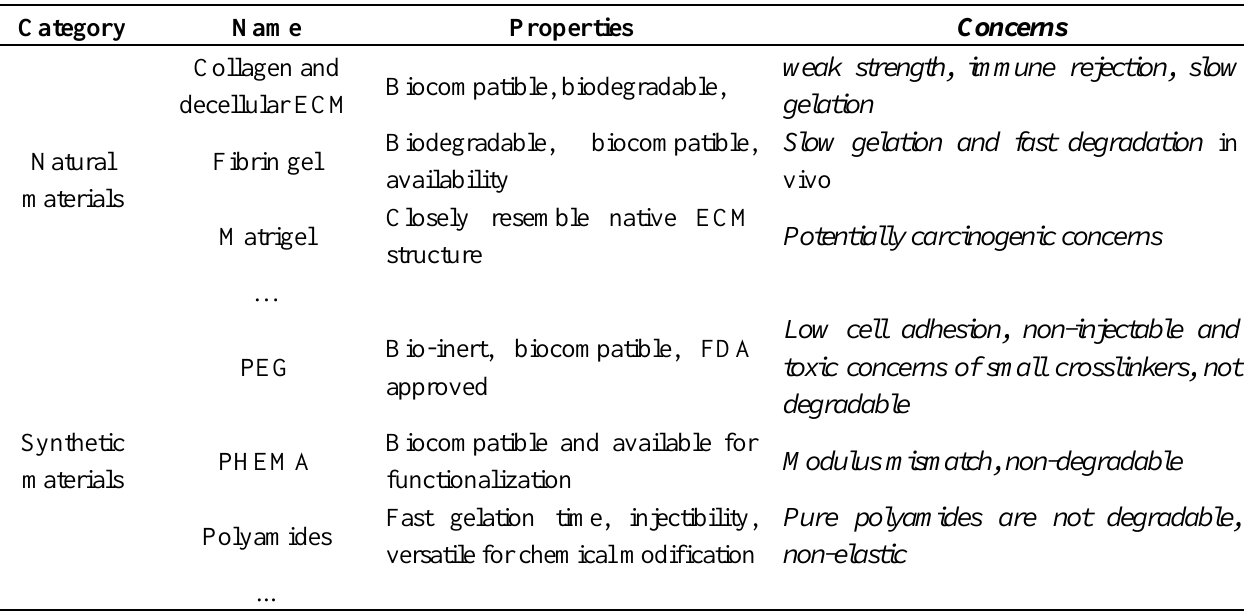
Table 2. Summary of commonly used hydrogels in cardiac tissue